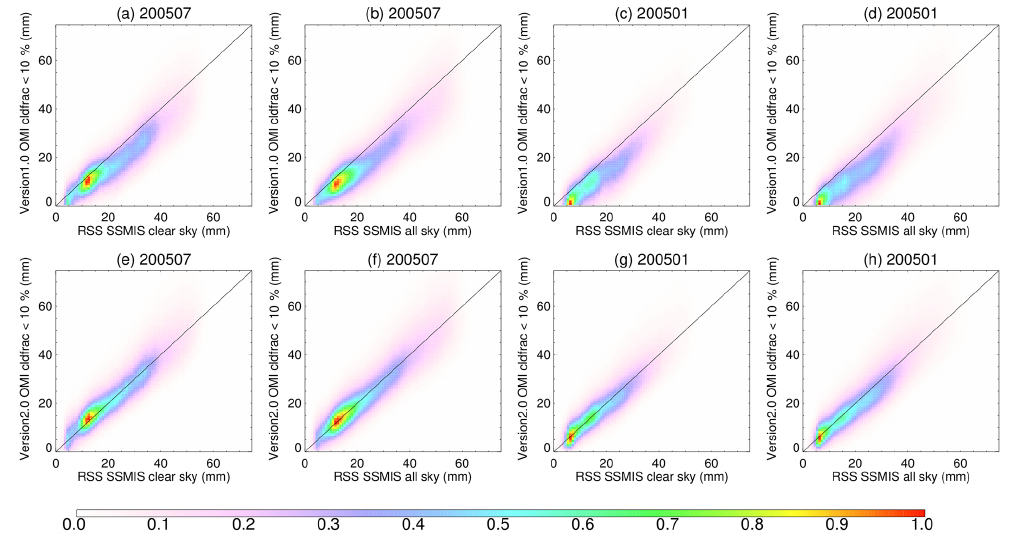
Figure 10. Two-dimensional normalized histograms derived from daily gridded (0.5 ◦ × 0.5 ◦ ) OMI (with cloud fraction < 10%) and SS- MIS data using 0.5mm × 0.5mm bins. The black line in each panel is the 1:1 line. (a) Version 1.0 OMI vs. “clear” sky SSMIS for July 2005; (b) version 1.0 OMI vs. all sky SSMIS for July 2005; (c) version 1.0 OMI vs. “clear” sky SSMIS for January 2005; (d) ver- sion 1.0 OMI vs. all sky SSMIS for January 2005; (e) version 2.0 OMI vs. “clear” sky SSMIS for July 2005; (f) version 2.0 OMI vs. all sky SSMIS for July 2005; (g) version 2.0 OMI vs. “clear” sky SSMIS for January 2005; (h) version 2.0 OMI vs. all sky SSMIS for January